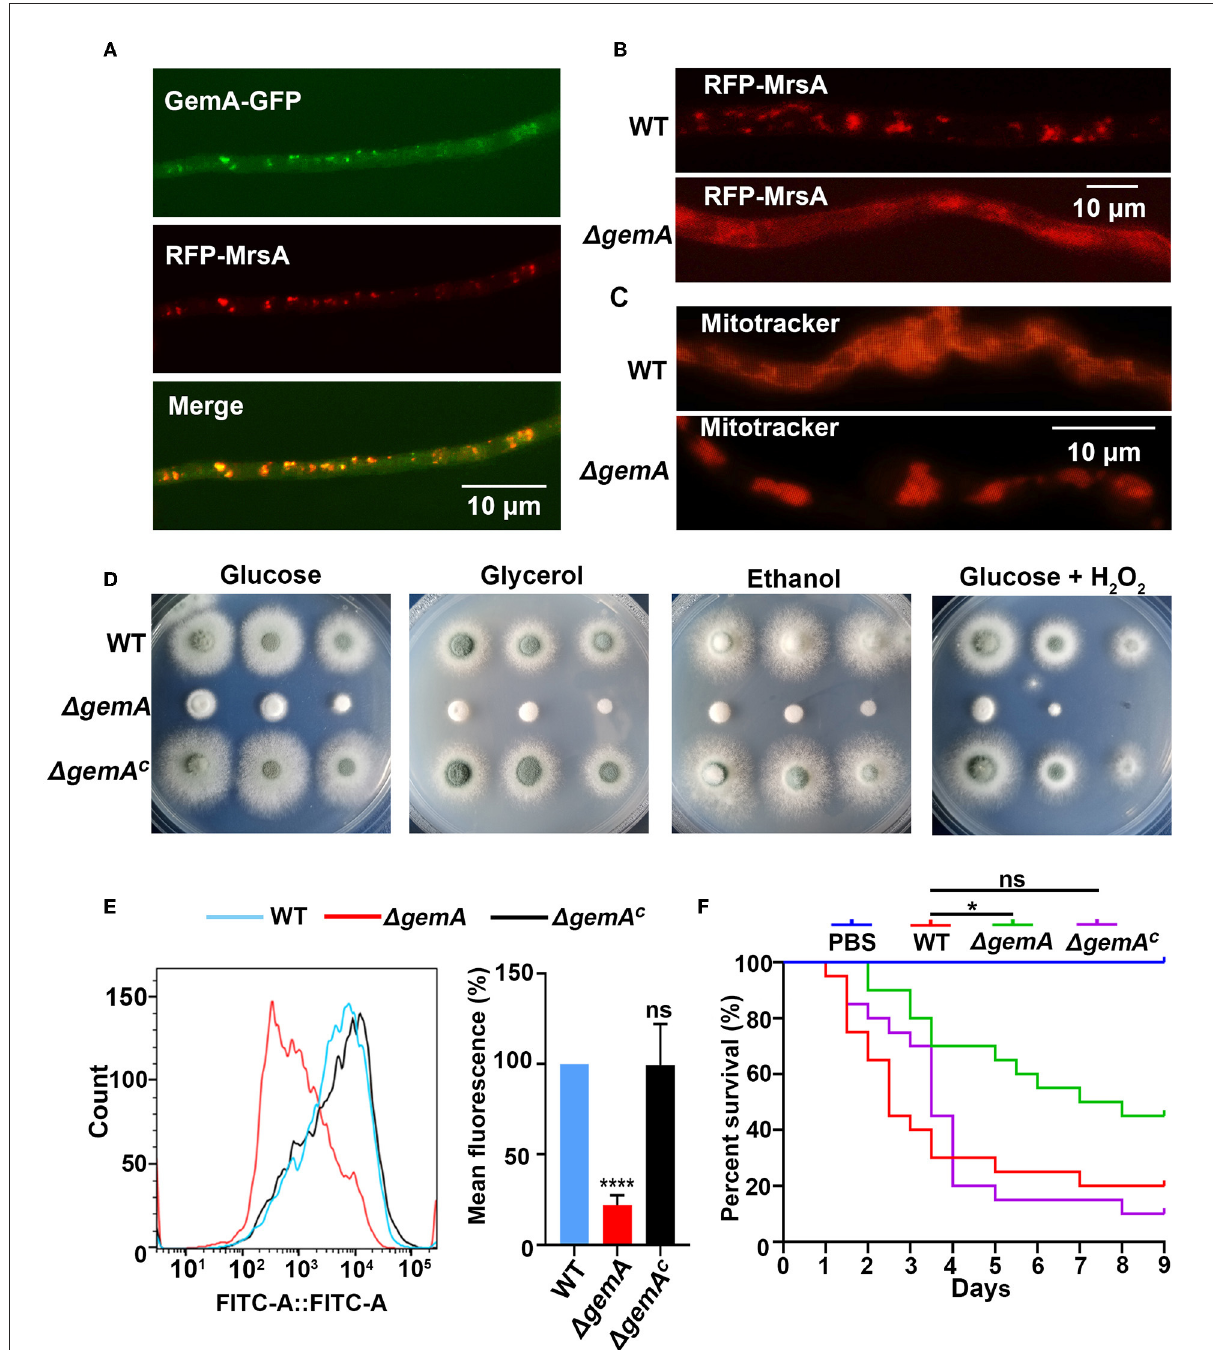
FIGURE2 Loss of GemA disrupted the mitochondrial function in A. fumigatus . (A) Subcellular localization of GFP-tagged GemA and (B) RFP-MrsA in the indicated strains. Bars, 10 µ m. (C) The mitochondrial morphological characteristics of the indicated strains. Mitochondria were stained by MitoTracker red. Bars 10 µ m. (D) Colony morphologies of the wild-type (WT) strain, 1 gemA , and gemA complementary strain cultured in MM containing different carbon sources (1% glucose, 1% glycerol, or 1% ethanol) or the oxidation reagents H 2 O 2 (3mM) at 37 ◦ C for 2 days. (E) The mitochondrial membrane potential was determined through flow cytometry. The fluorescence intensity value is shown on the x-axis. (F) Survival curve of G. mellonella infected with WT, 1 gemA , 1 gemA C , and PBS. ns, P > 0.05; * P < 0.05; **** P <